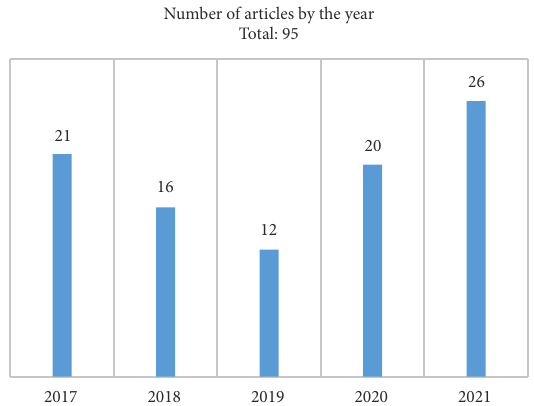
Figure 2. Year-wise distribution of research on SSCM in construction